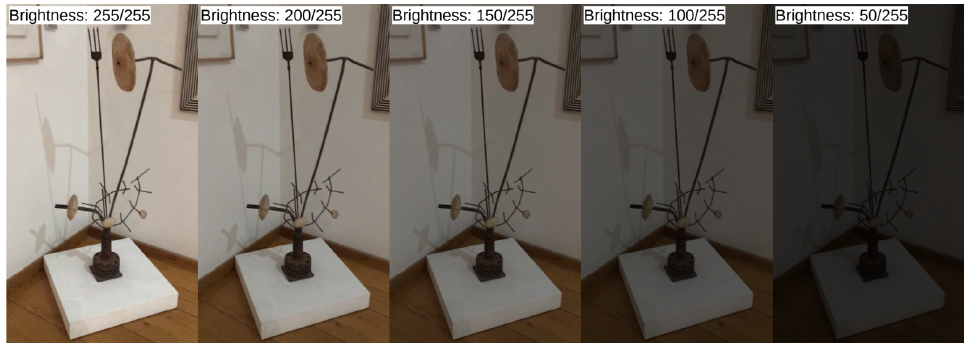
Figure 6. Example of the ambient light intensity variations in the hall.